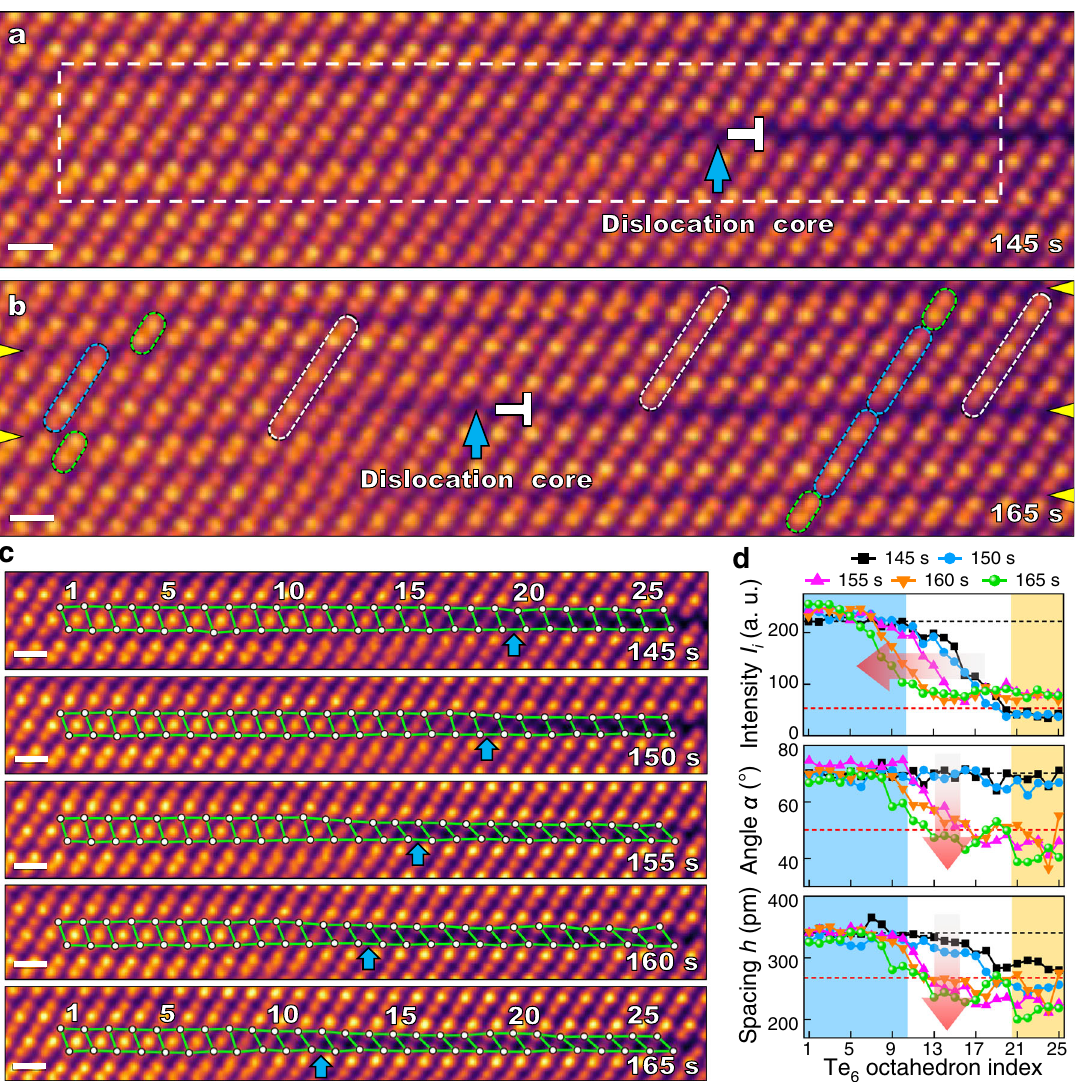
Fig. 2 | In situ STEM characterization of cations diffusion along a vdW gap. a , b ADF-STEM images acquired at 145 s and 165 s . The dislocation cores are indi- catedbycyanarrows.SLs,QLs,andDLsstructuresareindicatedbywhite,cyanand green rods, respectively. VdW gaps are indicated by yellow arrows. c A series of aligned ADF-STEM images around the dislocation core area (white dashed box in ( a ))from145 s to165 s .25Te 6 octahedronsatthedislocationcoreareaareindicated